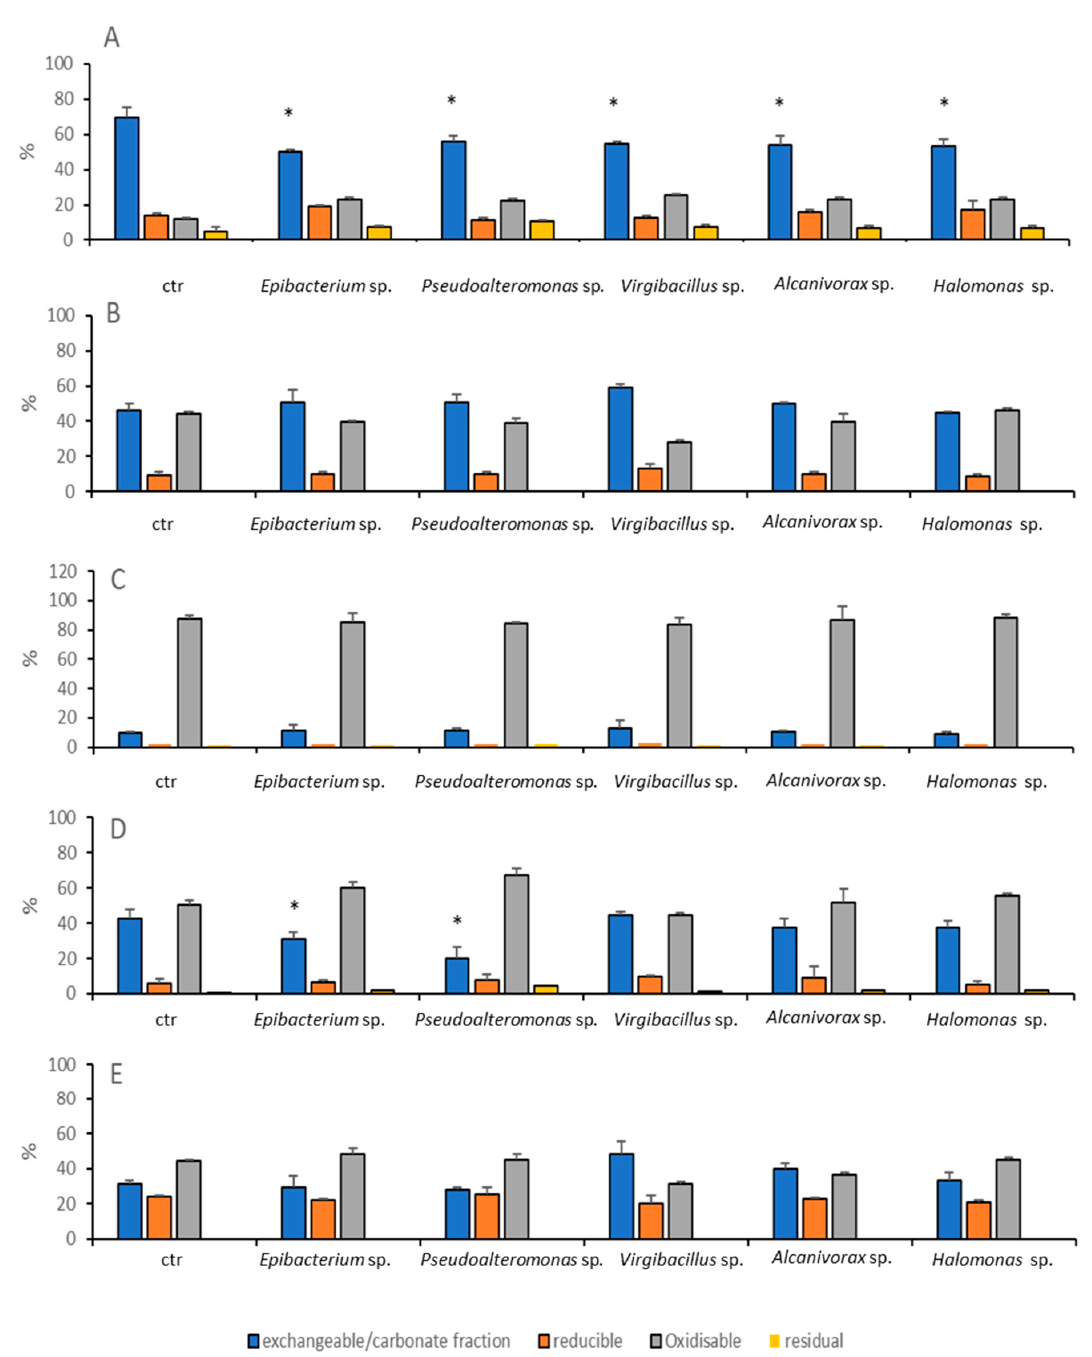
Figure 6. Heavy metal distribution in the four fractions (exchangeable / carbonate, oxidisable, reducible, and residual fractions) after 27 days of incubation of polluted sediments with the five bacterial strains: Epibacterium sp. SZN4, Pseudoalteromonas sp. SZN3, Virgibacillus sp. SZN7, and Halomonas sp. SZN1 and in the control (ctr). Panel ( A ), total arsenic; ( B ), cadmium; ( C ), copper; ( D ), lead; ( E ), zinc. The asterisk (*) indicates significant di ff erence between treatments and control.